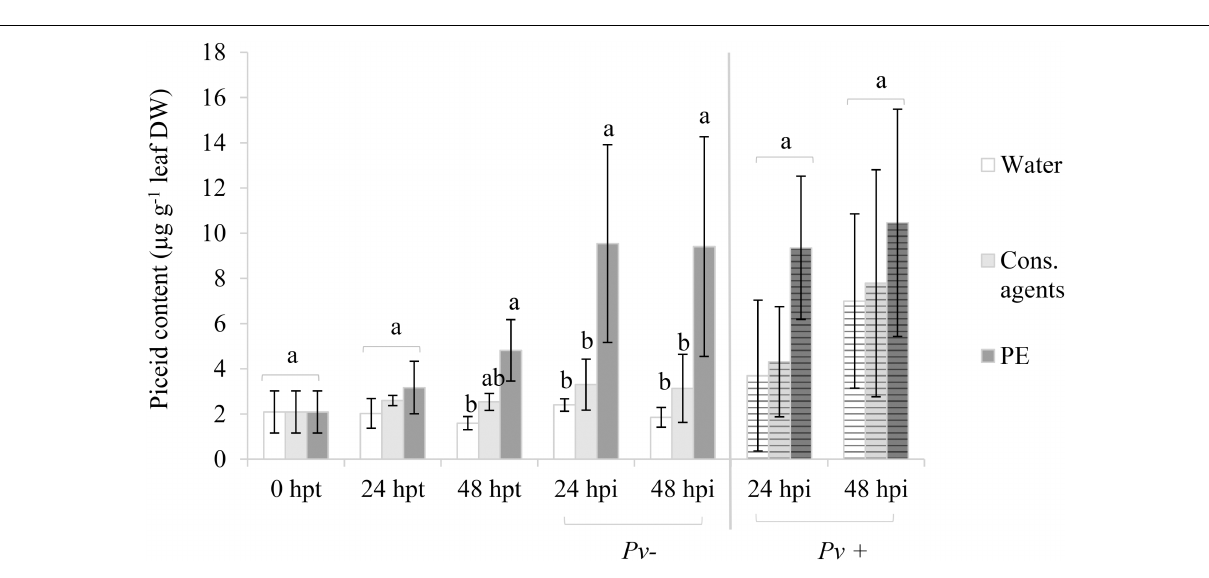
FIGURE 6 | Piceid accumulation in planta in response to PE treatment with or without P. viticola inoculation. Plants were treated with 5 g L − 1 PE, or equal volumes of cons. agents or water, and mock (Pv–) or P. viticola (Pv+) inoculated at 48 hpt. Leaves were collected at 24 and 48 hpt, and at 24 and 48 hpi. Piceid was analyzed by UPLC. Results correspond to the mean ± standard deviation of three independent biological repetitions. Significant differences ( p ≤ 0.05) were identified with Kruskal–Wallis coupled with Dunn’s multiple comparison test. Conditions with different letters are significantly